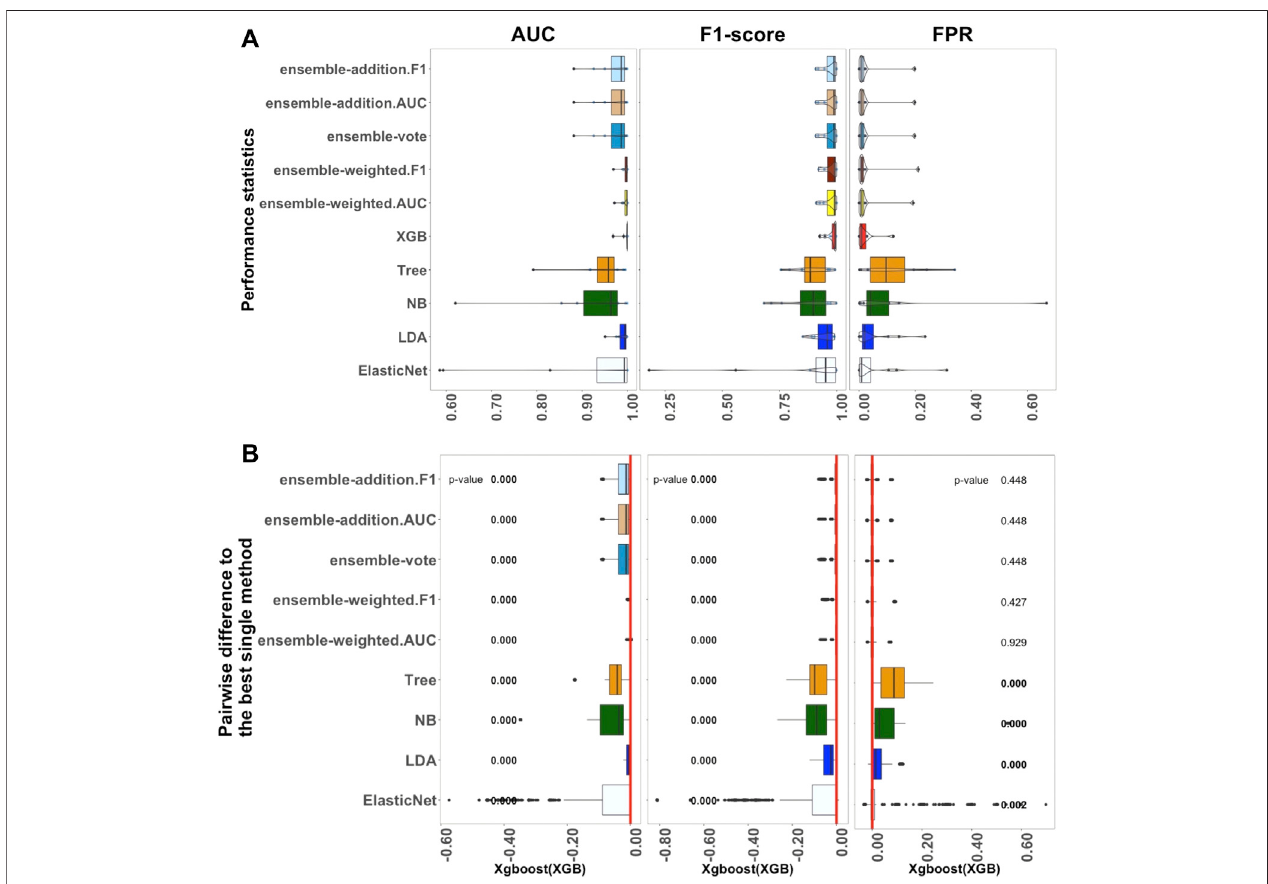
FIGURE3| Performanceoftenalgorithmswiththe12largedatasets.Thevaluesofthreecriteria(AUC,F1-score,andFPRfromlefttoright)areshownin (A) .There are1,200pointsineachbox.Thevaluesofthreecriteriawereusedtorepresenttheperformanceofthecorrespondingalgorithm. (B) Differencesbetweenthebestsingle algorithmandtheotheralgorithms.Fromlefttoright, theresultsshowthedifferencesinAUC,F1,andFPRincludingthe p valuesfrom theWilcoxontest; p values < 0 . 05 are indicated in bold, and the red lines indicate the zero value. The best single method is shown at the bottom of each box.